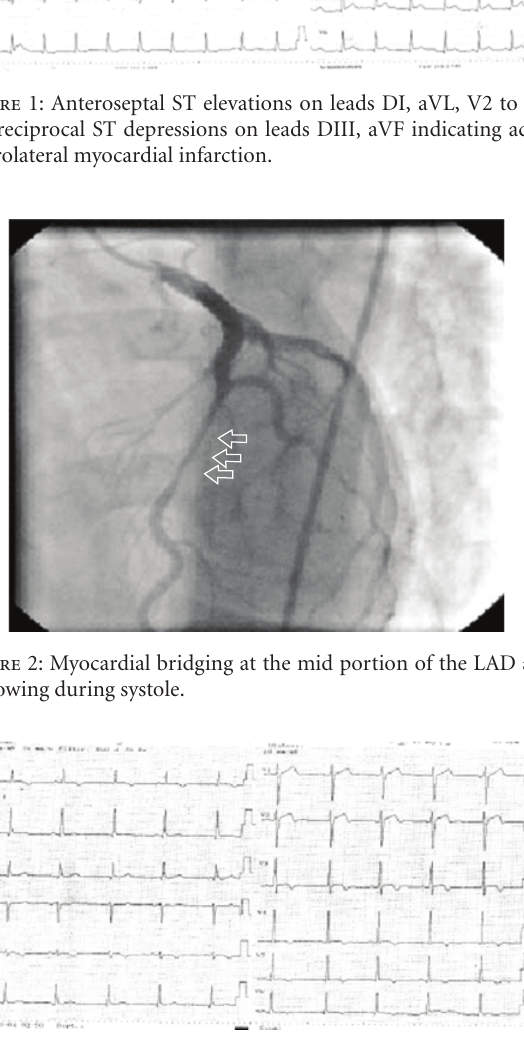
Figure 3: Normal resolution phase of anterolateral myocardial infarction as biphasic T waves on leads V2 to V6 and DI,